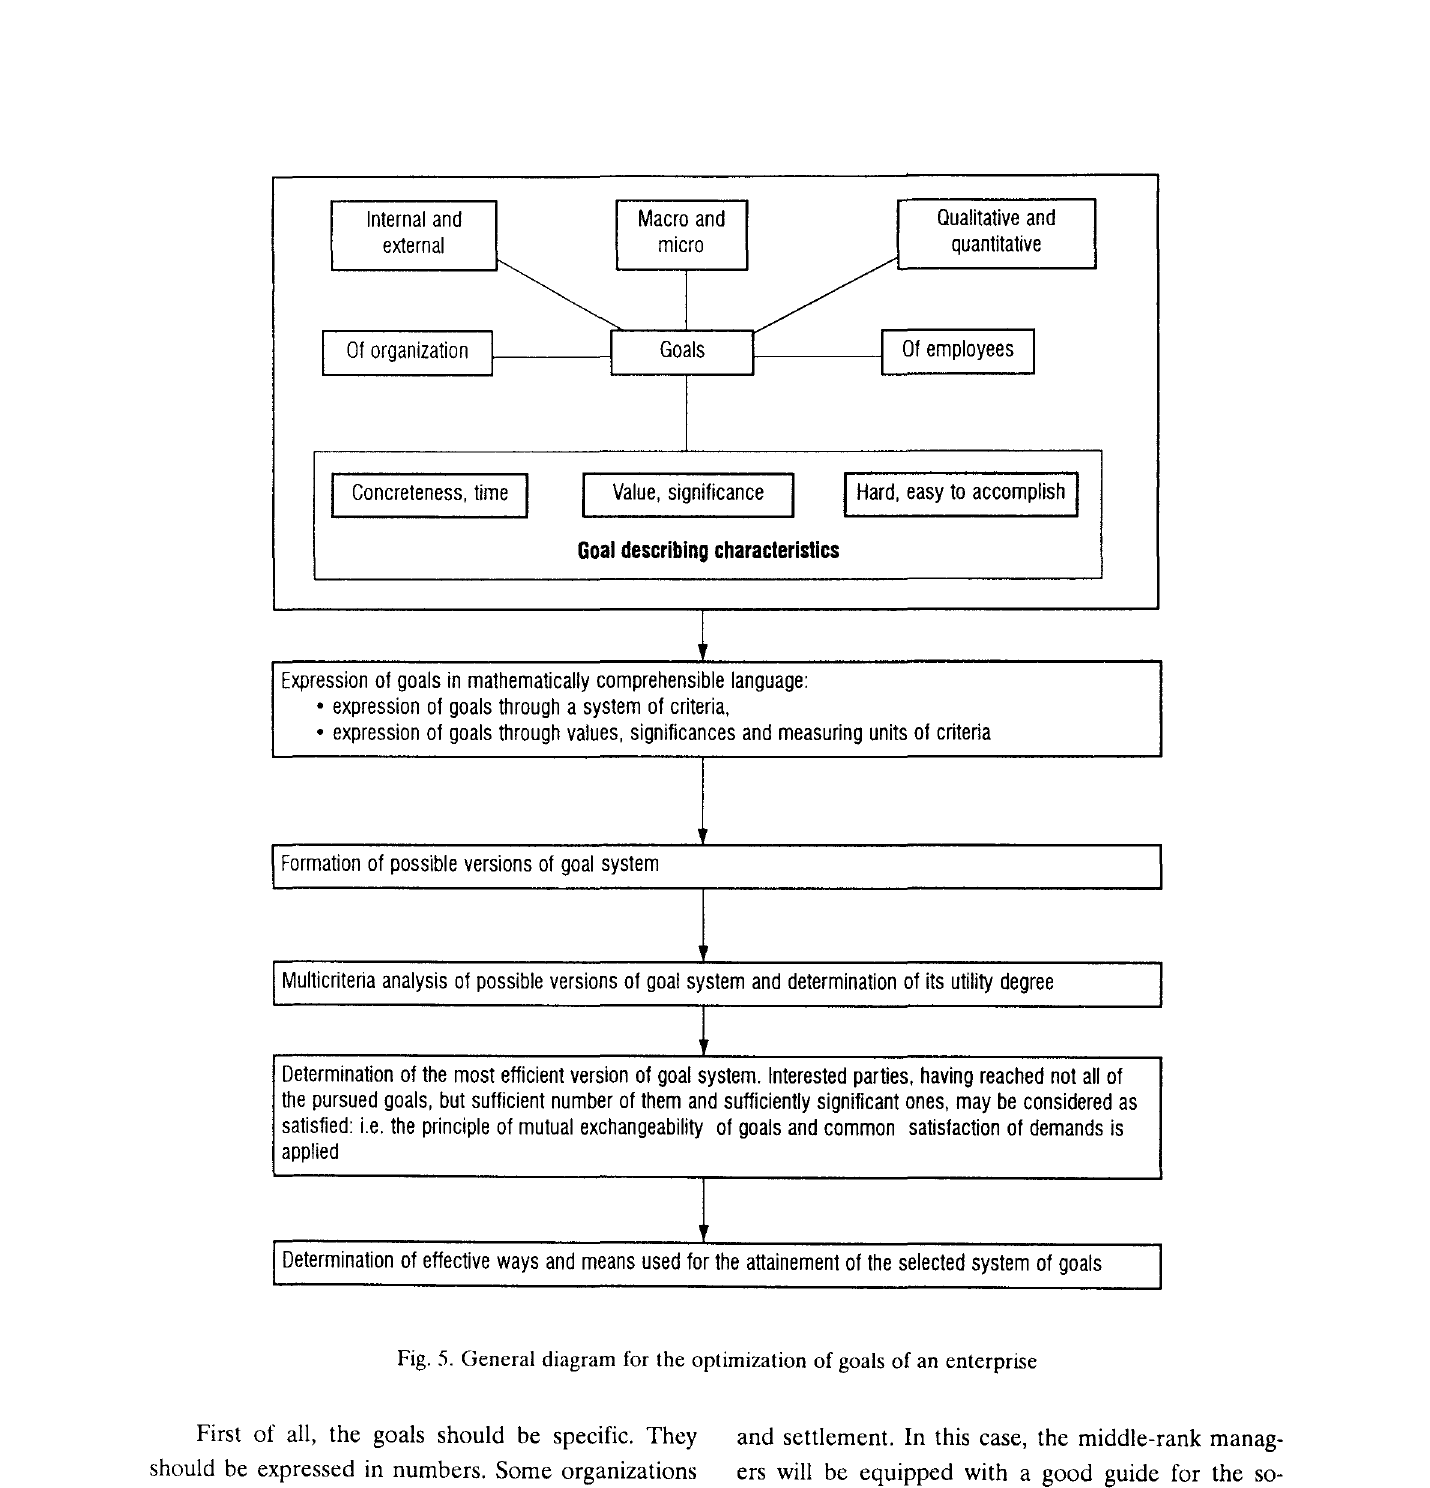
Fig. 5. General diagram for the optimization of goals of an